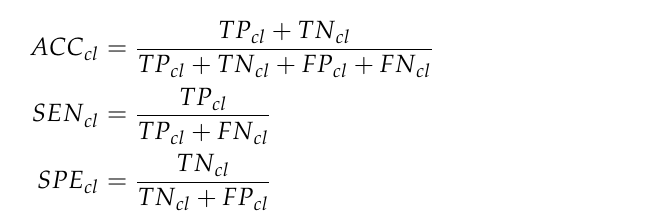
indicates the sum over all Test Folds. (cid:104) Test Fold (cid:105) Predicted